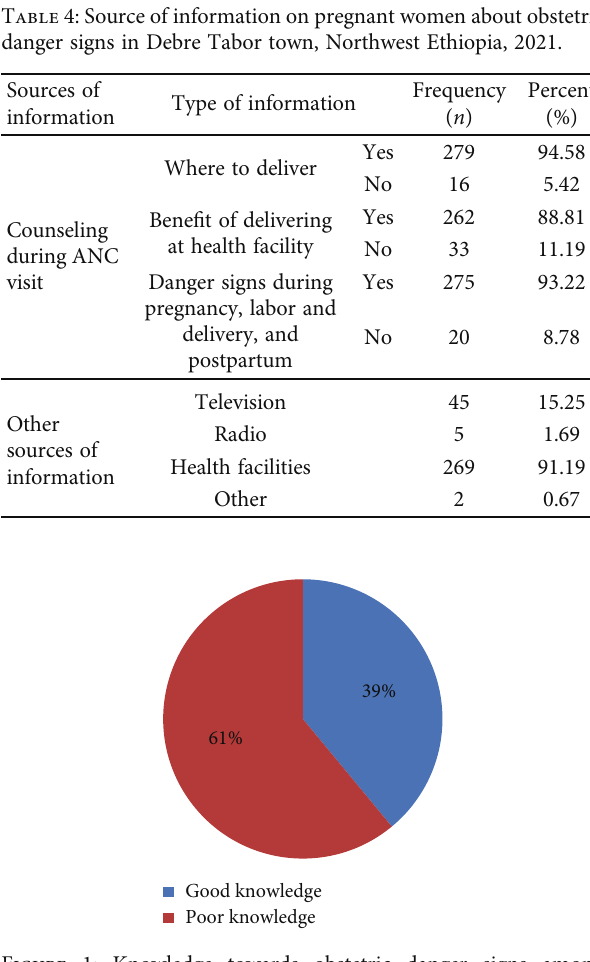
Figure 1: Knowledge towards obstetric danger signs among pregnant women in Debre Tabor town, North West Ethiopia,